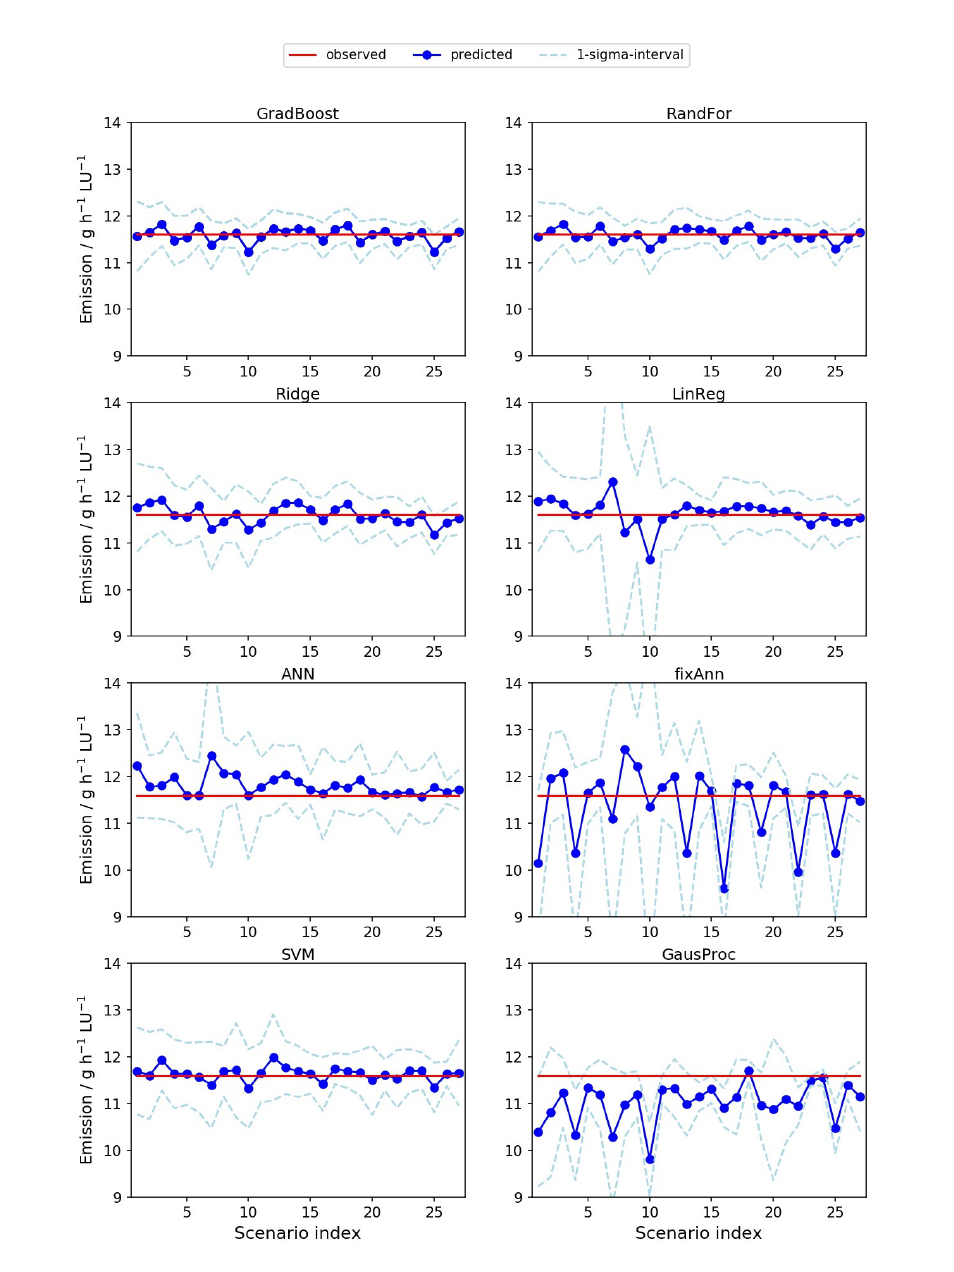
Figure 3. Predictions of methane emissions [g h − 1 LU − 1 ] averaged over the 10 month measuring period with eight regression methods. The mean over the predictions, based on 30 random realizations of each of the 27 scenarios (as depicted in Figure 1), is highlighted in blue. The associated one-sigma intervals are indicated by the light blue dashed lines. Here, all methods used the features: T (i.e., outdoor temperature), T 2 , wind speed, wind direction, time and day-time, scaled with the RobustScaler from Scikit-learn [25]. For comparison, red horizontal lines highlight the mean observed emission ( ¯ E n =11.6 g h − 1 LU − 1